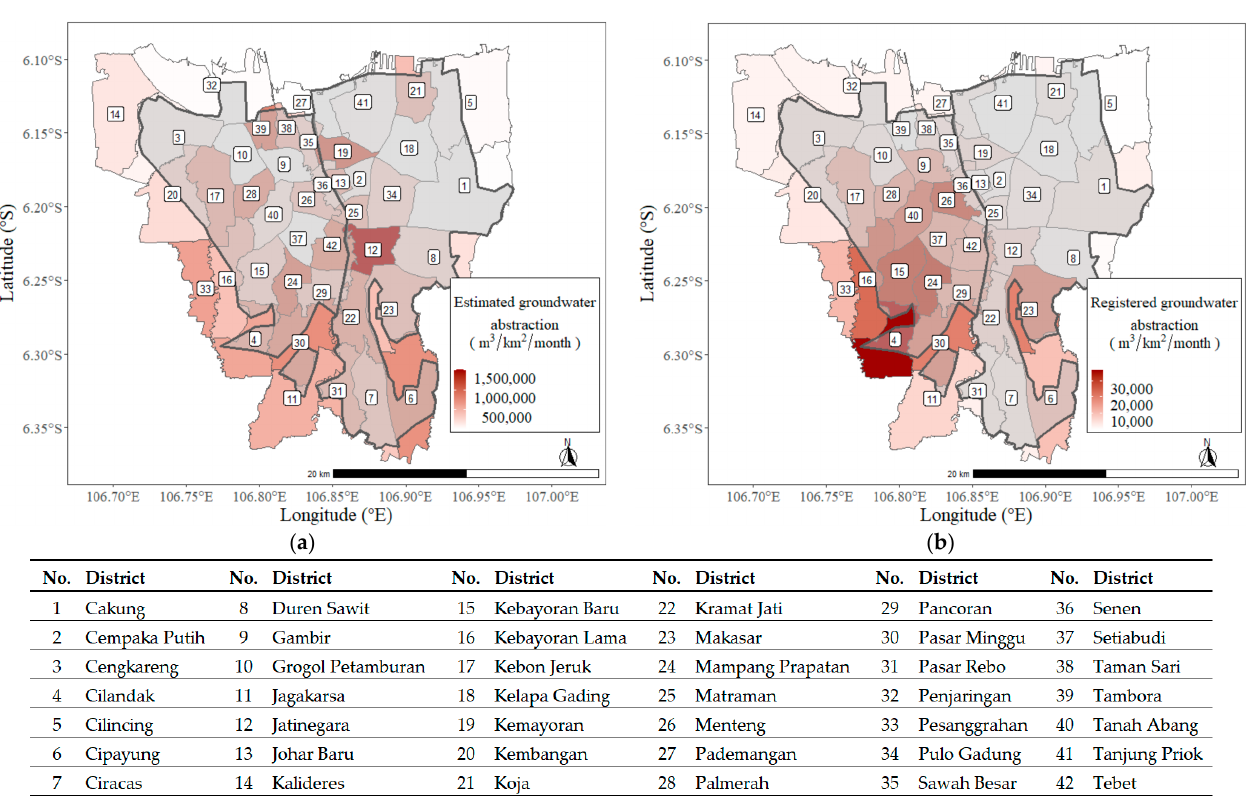
Figure 4. ( a ) Estimated groundwater abstraction per month in each district. ( b ) Registered ground- water abstraction per month in each district.